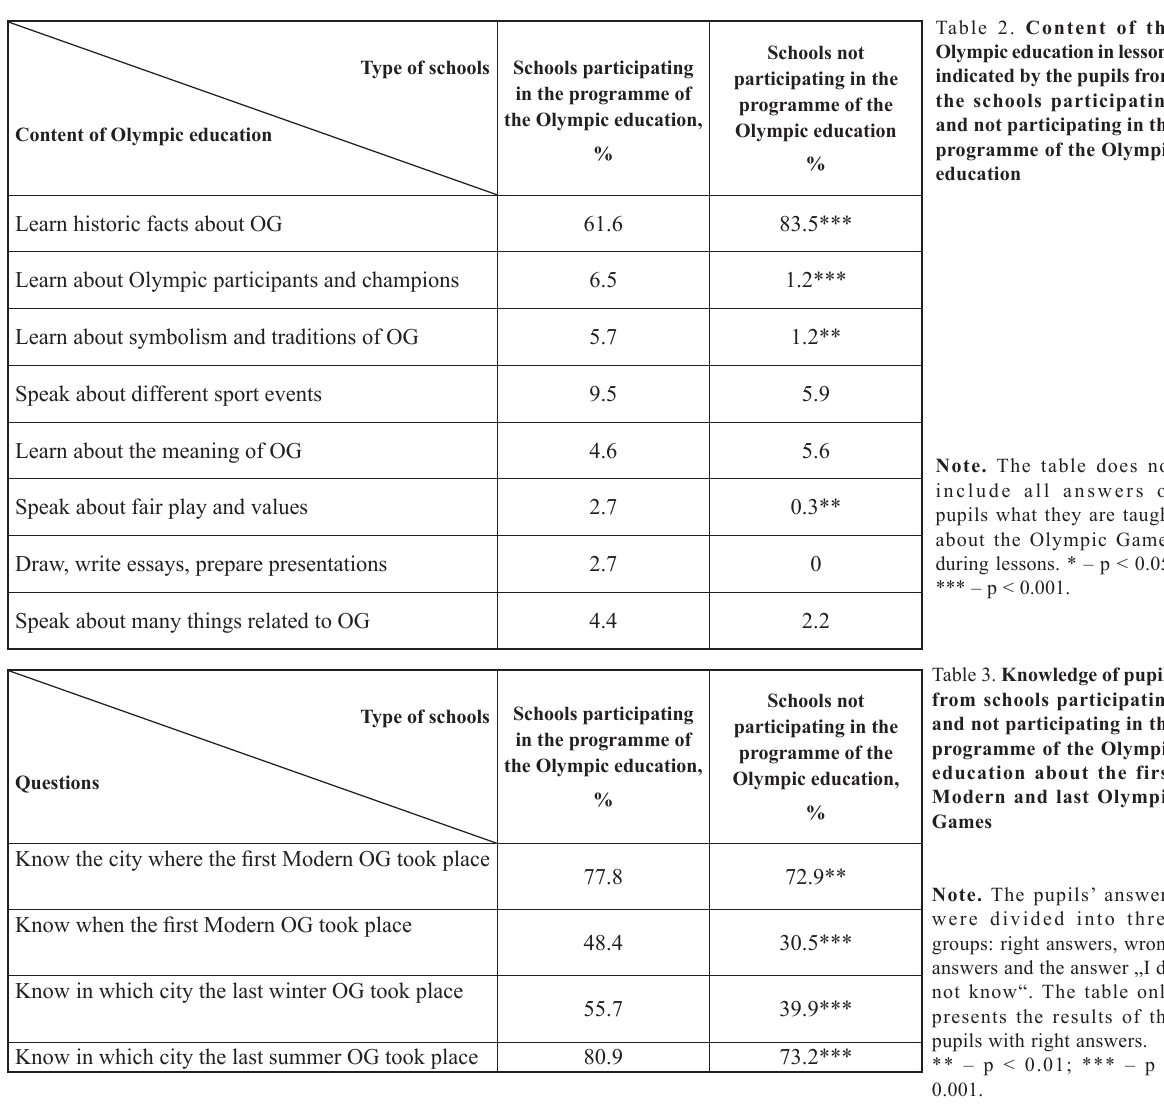
Table 2. Content of the Olympic education in lessons